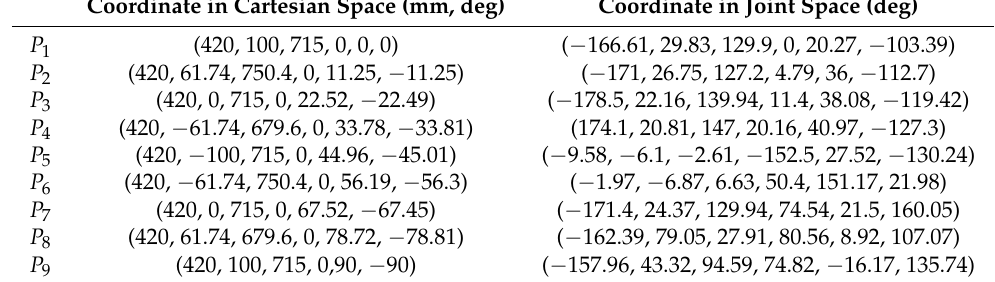
Coordinate in Joint Space (deg)